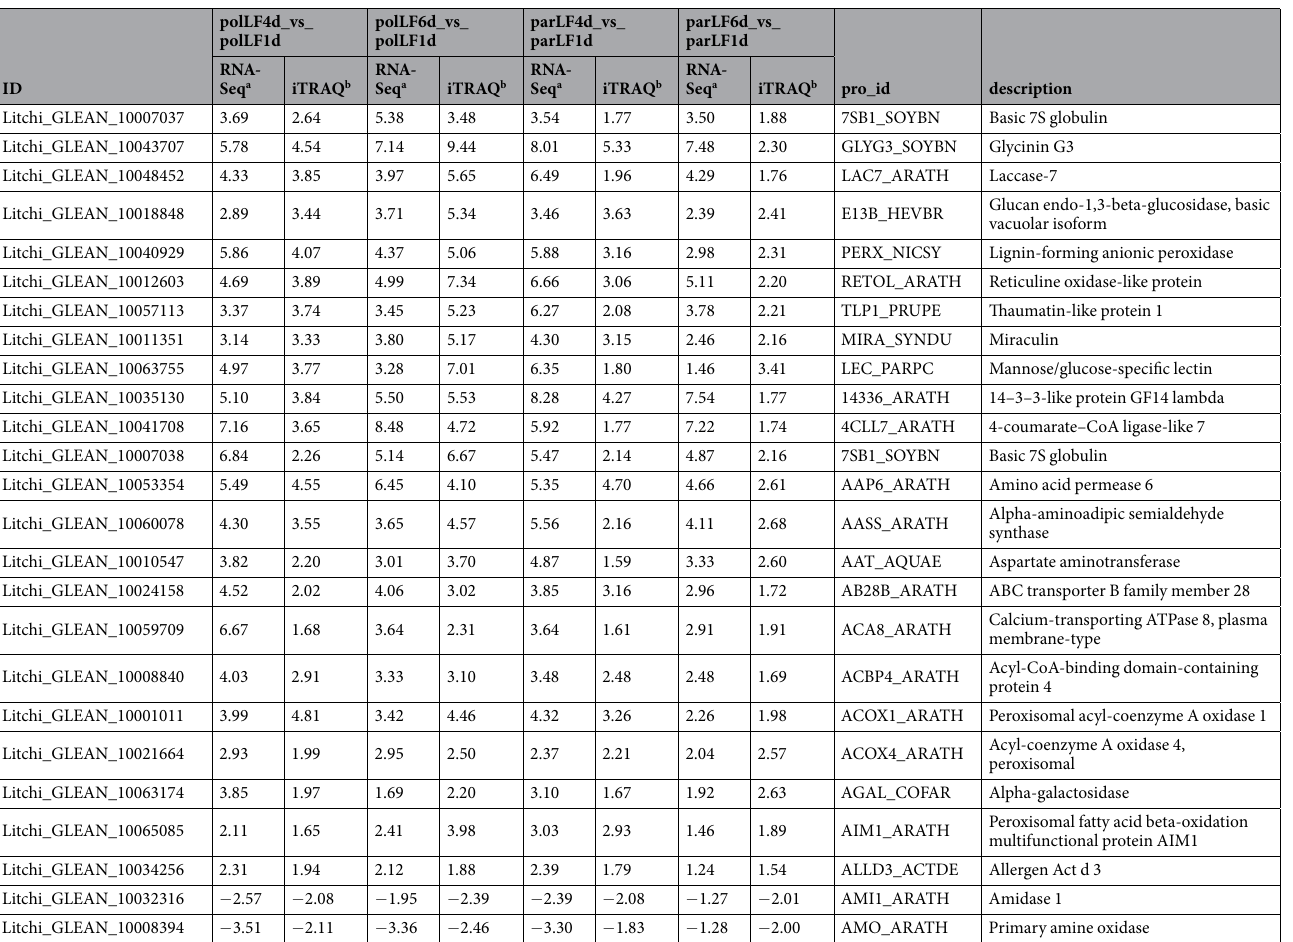
Table 5. Consistent DEGs/DEPs in both polLFs and parLFs. a Fold change of gene expression identified by RNA-Seq. b Ratio of protein expression identified by